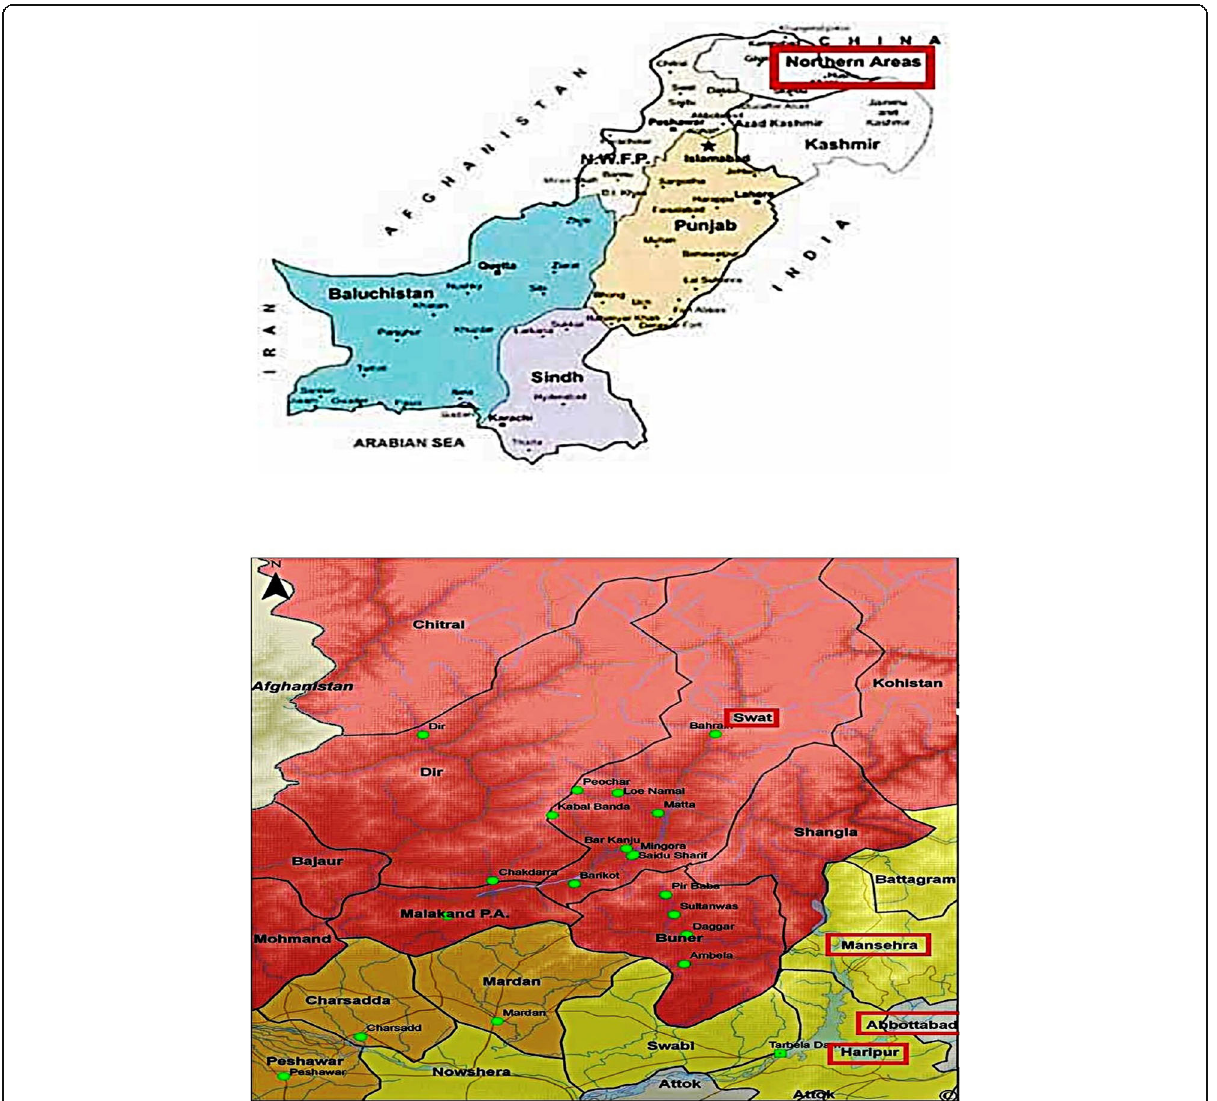
Fig. 1 Map of the study area -Northern Pakistan